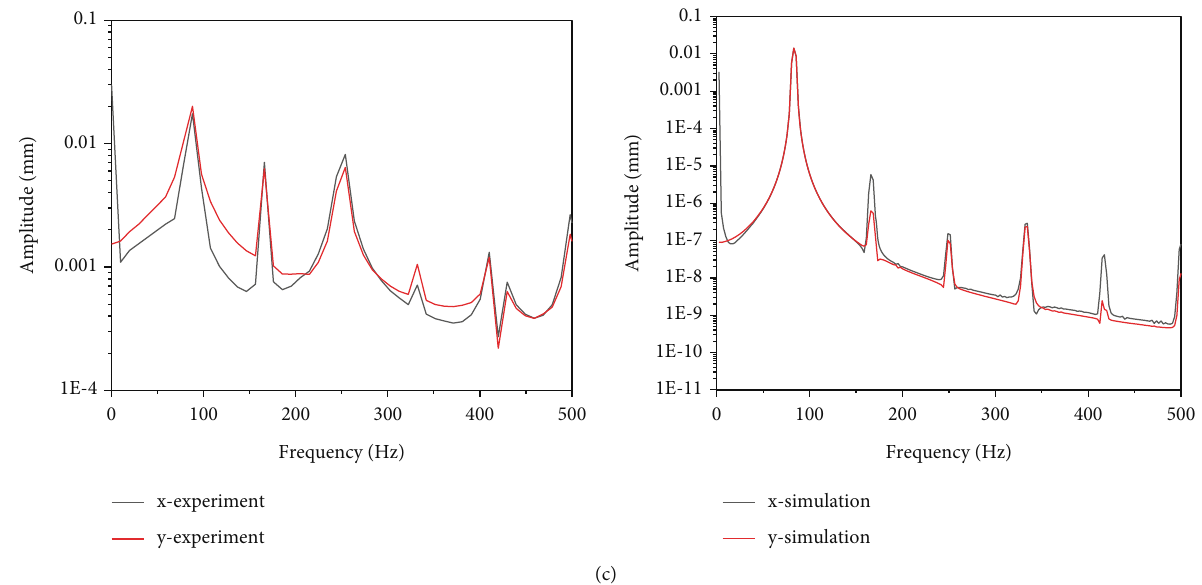
Figure 15: Spectrogram of the shaft for case 2. (a) Subcritical speed. (b) Critical speed. (c) Supercritical